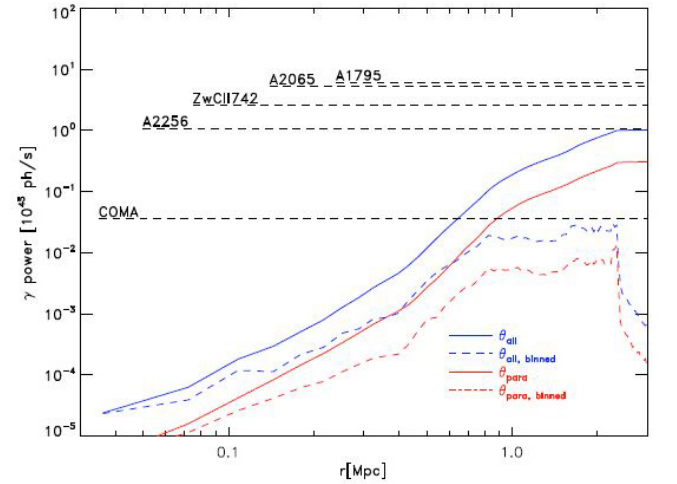
Figure 3. Profiles of the γ -ray emission. The solid lines show the total integrated emission profiles and the coloured dashed lines show the radial emission profiles. The γ -ray emission produced by cosmic-ray protons accelerated in all shocks is given by the blue lines. The red line shows the case of only quasi-parallel shocks being able to accelerate cosmic rays. The black dashed lines show the upper Fermi -limits for galaxy clusters that have a comparable mass to our simulated